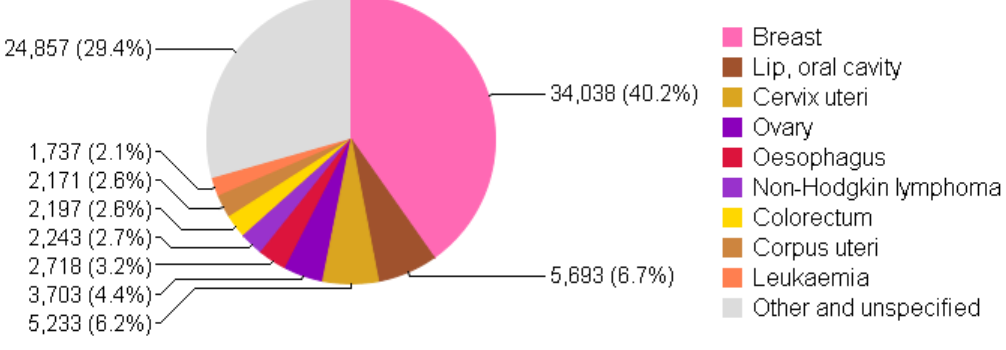
Figure 1. Incidence of cancer in females of all ages in Pakistan (per 100,000) (chart adapted from [10]).